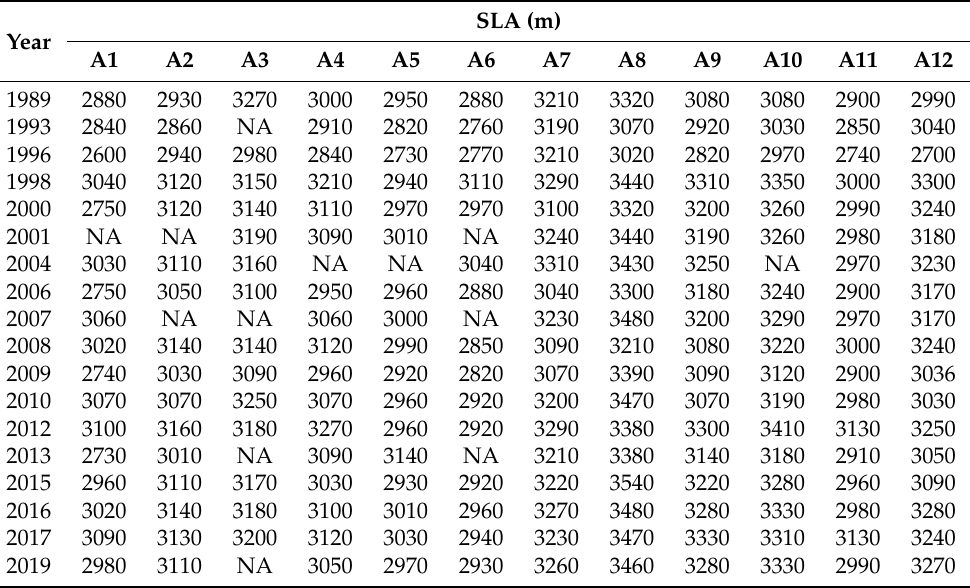
Figure 5. Glacier SLAs that were extracted from the Sentinel-2 images during the ablation season. Table 3. SLAs for the 12 analyzed glaciers across the Altai Mountains during the 1989–2019